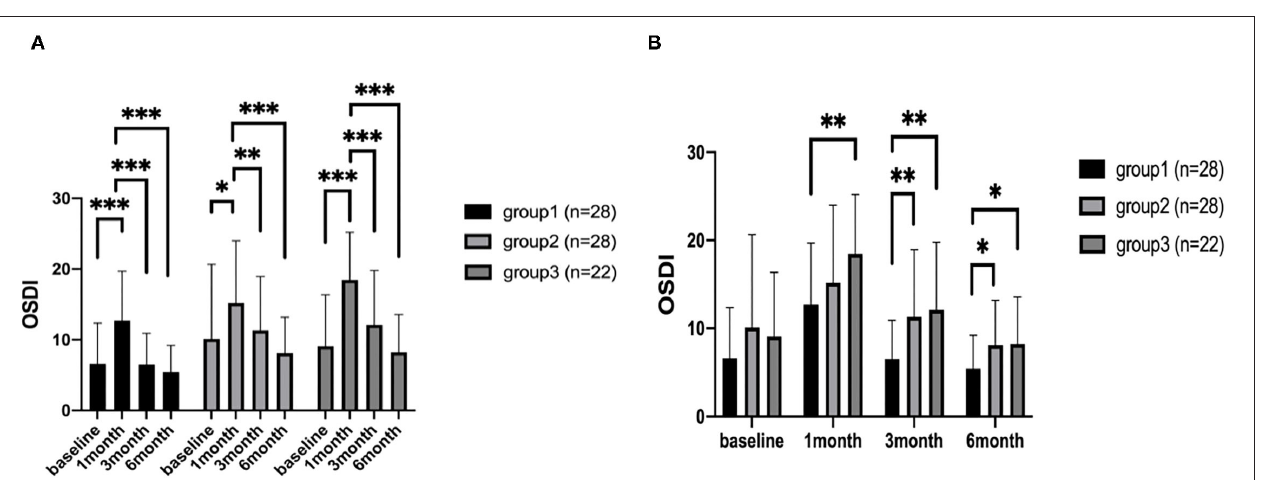
the age, the gender and other basic parameters of subjects in each group ( Table 1